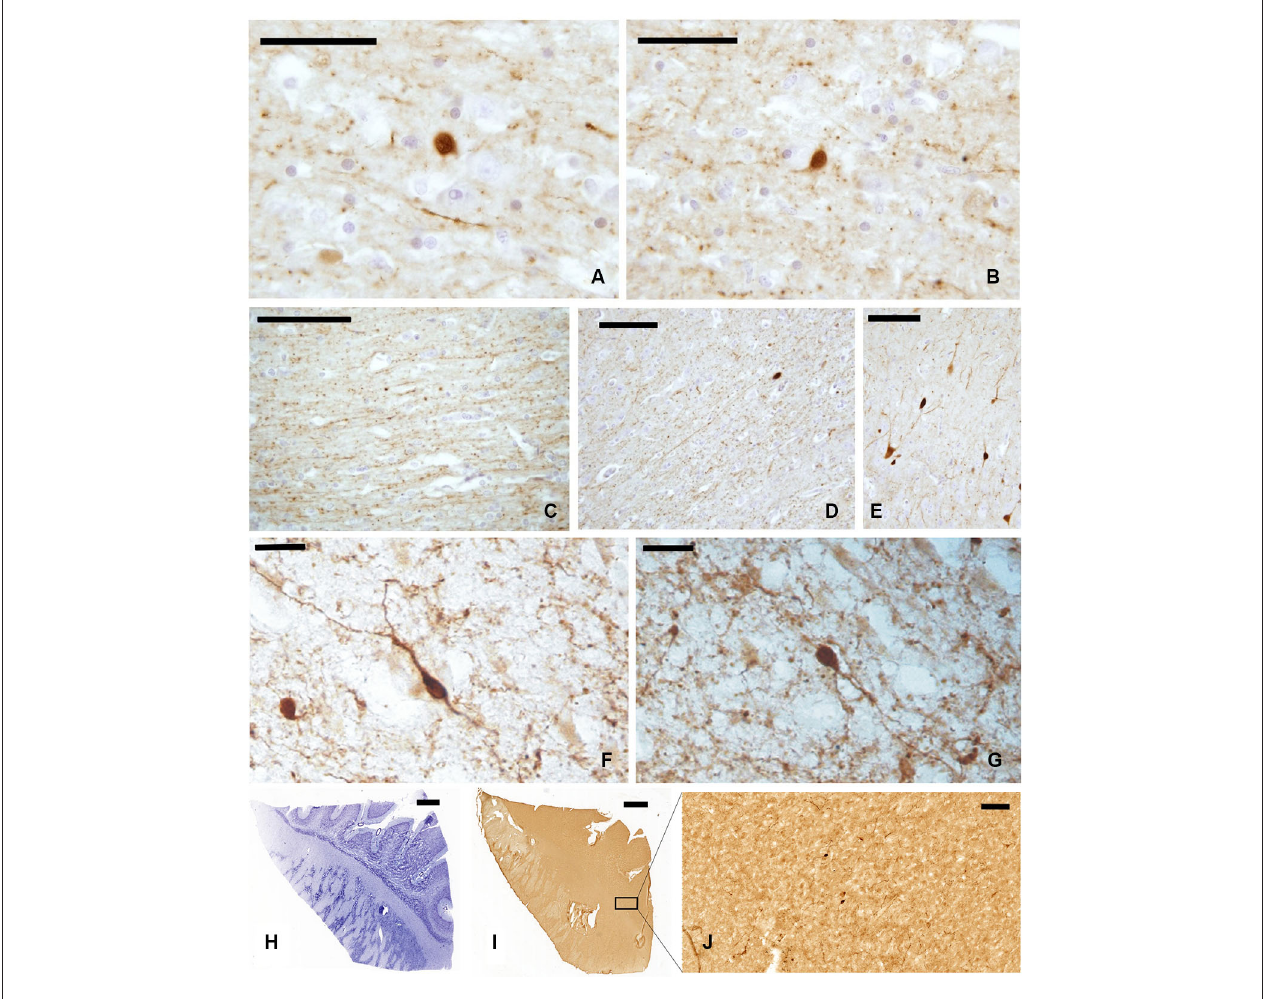
neurons in frozen sections; (H–J) localization of CR-ir neurons in whole sections ( (H) Nissl stain, (I–J) immunocytochemistry); J represent an enlargement of the black rectangle in I Scale bars: A, B = 50 µ m; C, D, E, J = 100 µ m; F, G = 20 µ m; H, I = 2 mm.